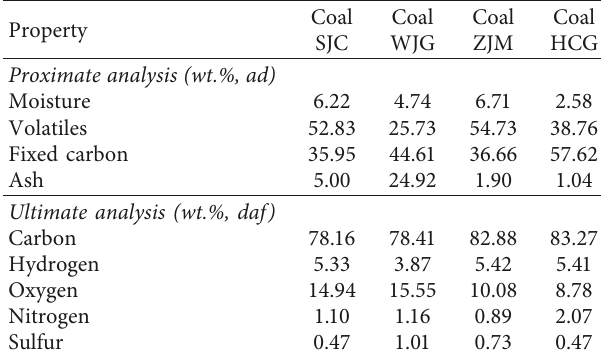
Table 1: Proximate and ultimate analyses of coal